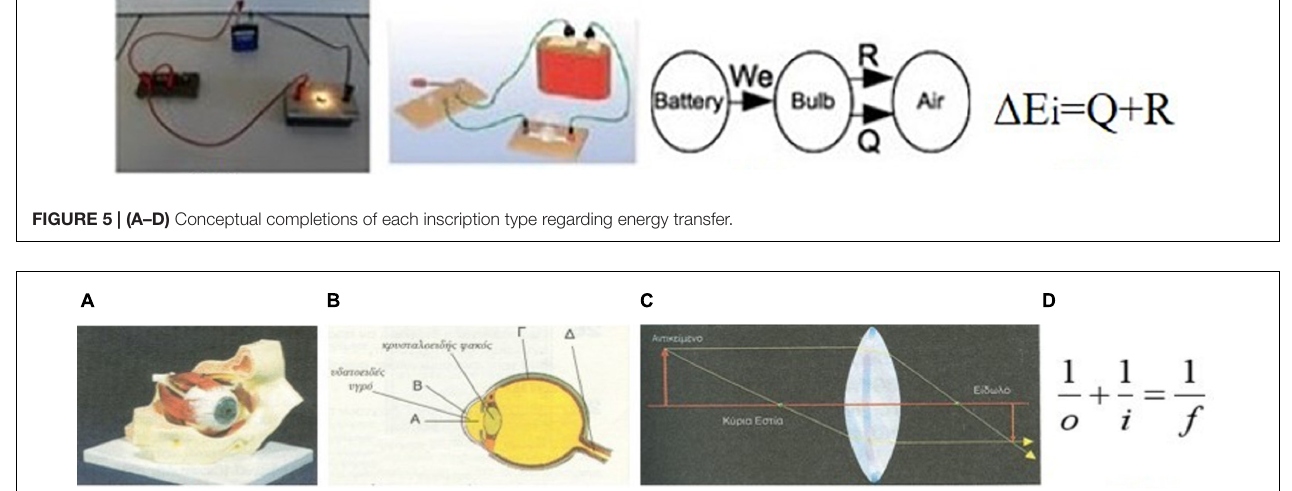
FIGURE 6 | (A–D) The synergy of inscriptions for storytelling the eye as a